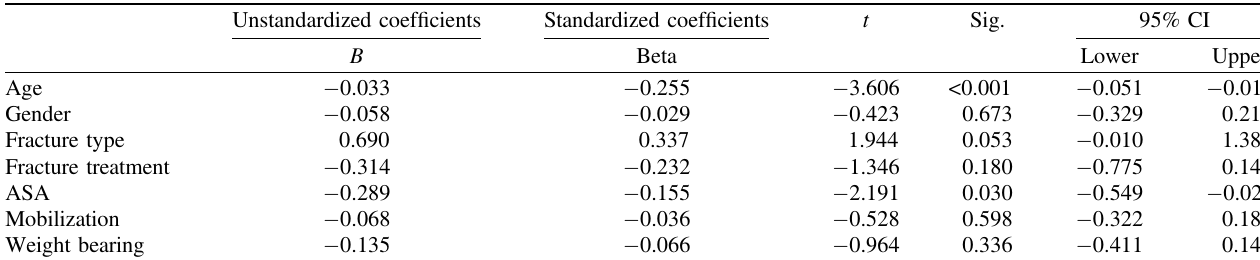
Table 6. Predictors for ability to walk. Unstandardized coef fi cients